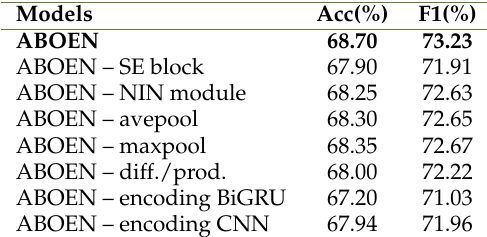
Table 4. Ablation study on NCSS dataset.